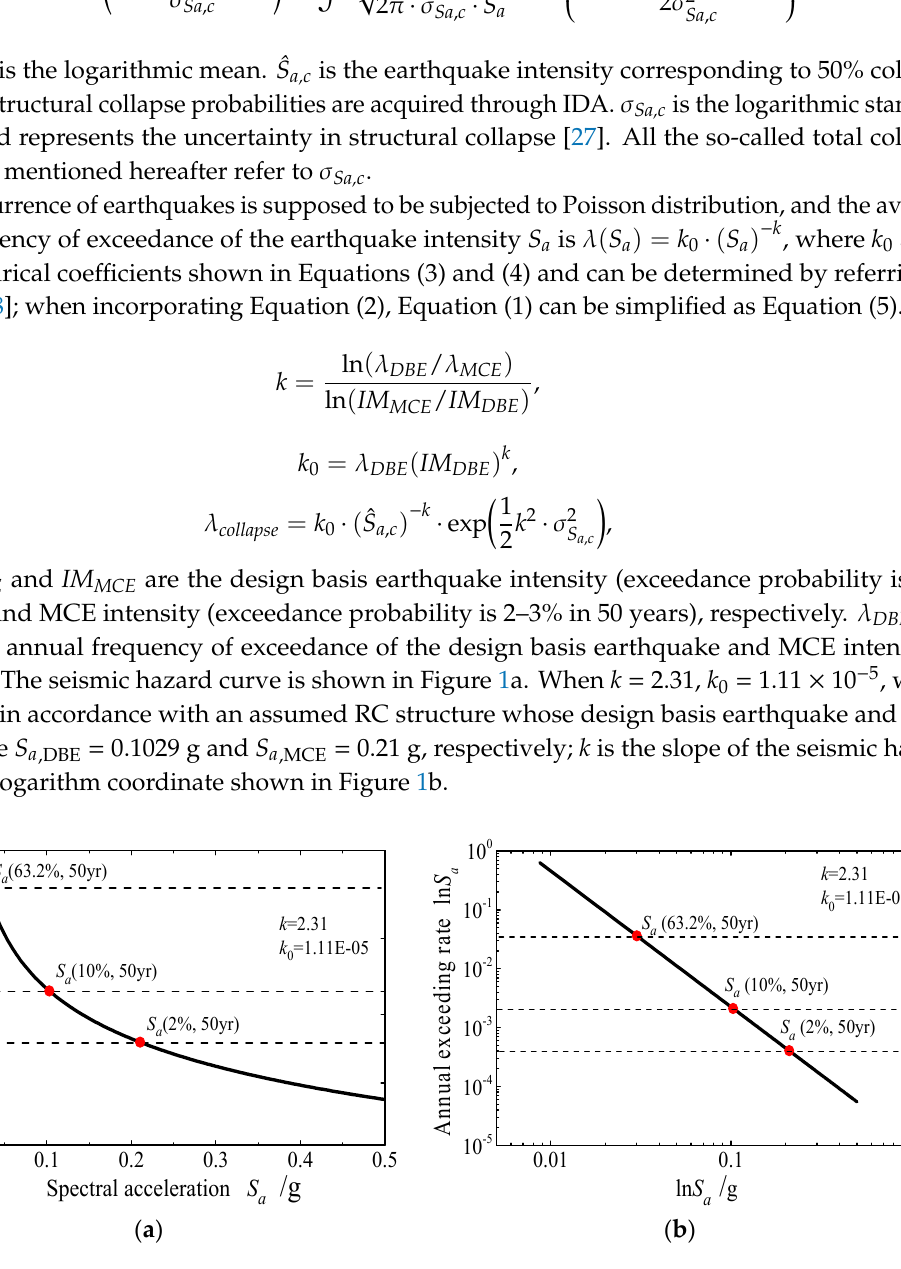
Figure 1. Seismic hazard curves: ( a ) Seismic hazard curve in the linear coordinate; ( b ) Seismic hazard curve in the log–log